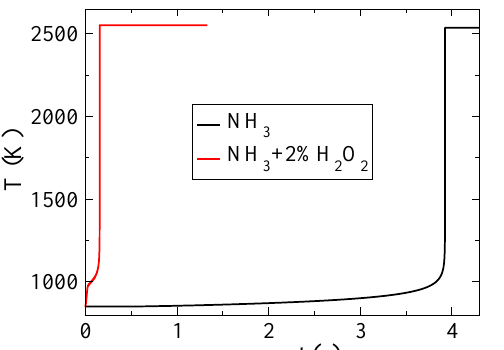
Figure 1. Temperature evolution during autoignition of (i) pure NH 3 -air and (ii) NH 3 -air with 2%H 2 O 2 mixtures